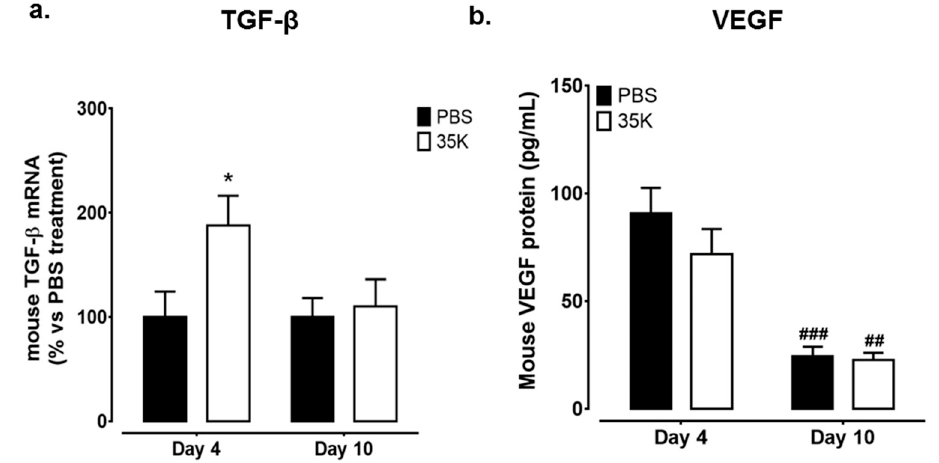
Figure 3. Modulation of pro-angiogenic markers following inhibition of CC-chemokines by 35K in early and late stage wounds. RNA and protein were isolated from PBS and 35K treated wounds at both the early (Day 4) and late (Day 10) time points ( n = 12/time point); ( a ) real-time PCR was used to measure mRNA levels of TGF- β ; ( b ) vascular endothelial growth factor (VEGF) protein levels were detected by ELISA. Data is represented as mean ± SEM. Statistical analysis was performed by an unpaired two-tailed t -test. ## p < 0.01, ### p < 0.001 compared to respective treatment group wounds at Day 4. * p < 0.05 compared to PBS treated wounds.